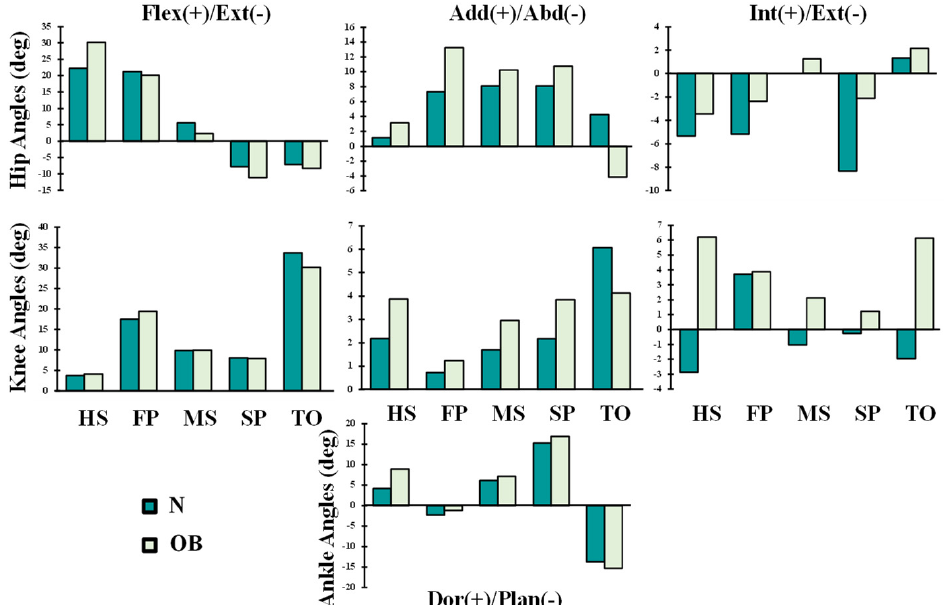
Figure 2. Lower extremity joints’ angles reported as the mean of normal-weight (N) and obese (OB) subjects during the stance phase of gait [43]. Five instances corresponding to the beginning heel strike (HS), first loading peak (FP), midstance (MS), second loading peak (SP), and toe-off (TO) of the stance phase are indicated.